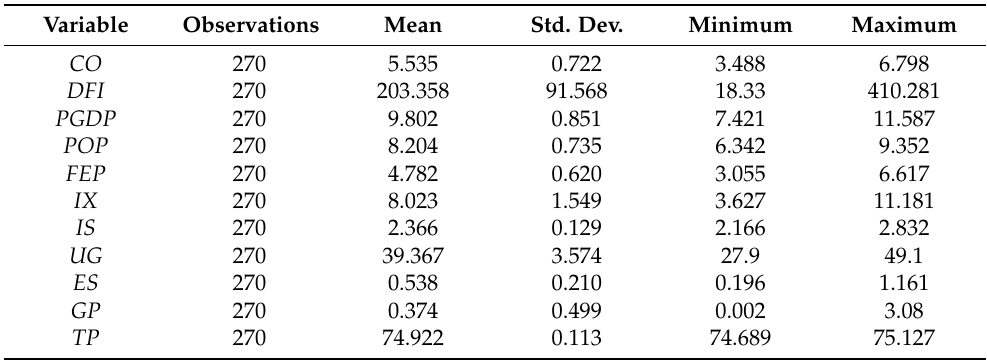
Table 2. Descriptive statistics of main